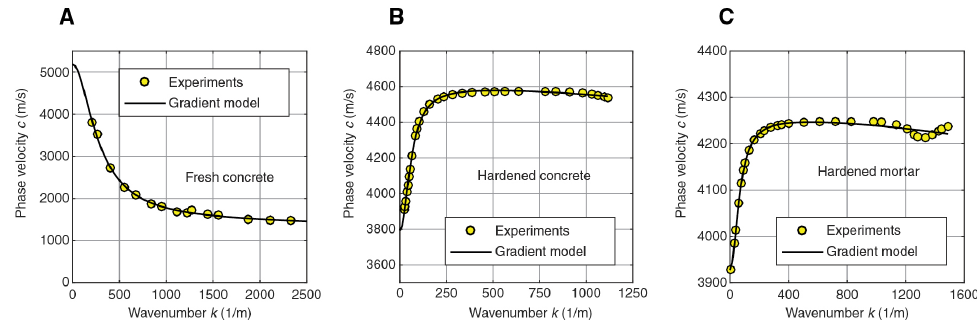
Figure 3: Experimental dispersion curves for fresh concrete [7], hardened concrete and hardened mortar [8] vs. simula- tions with proposed gradient elasticity